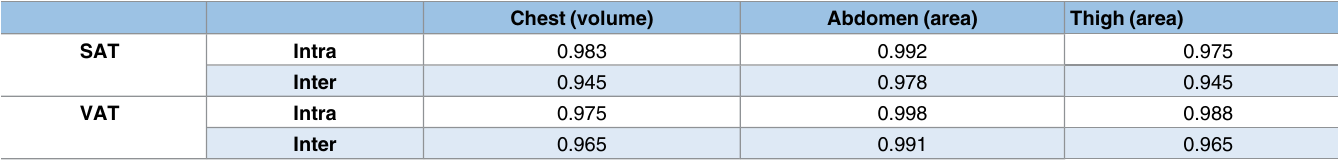
Table 3. Intra- and inter-operator repeatability (precision [44]) in SAT and VAT measurement in repeated